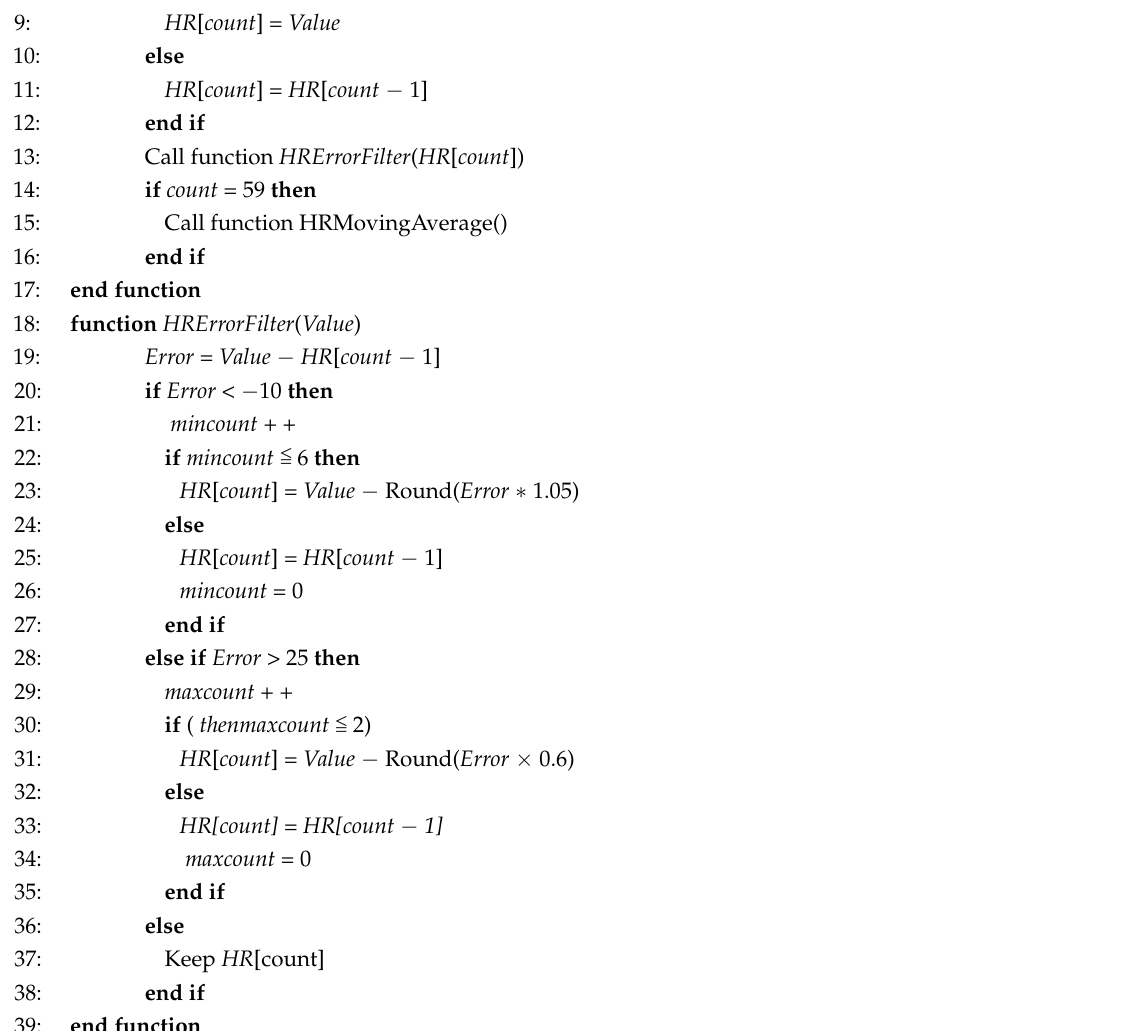
Algorithm 1 Heart rate filtering 1: Global Variables: